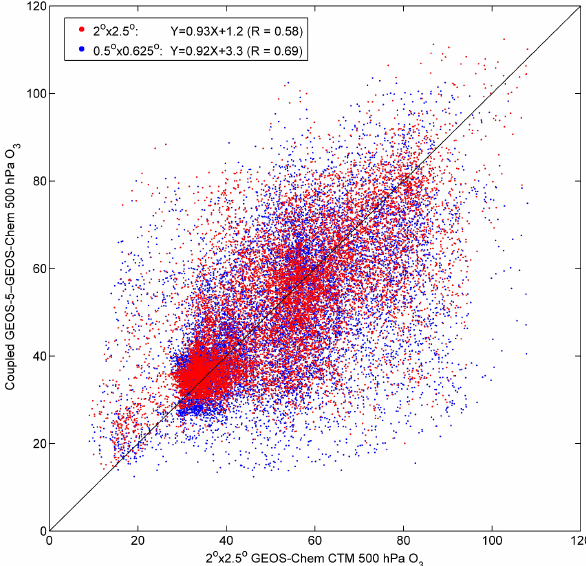
Figure 4. Comparison of instantaneous 500hPa ozone mixing ra- tios (nmolmol − 1 ) at 12:00UT on 15 July 2006 in the stand-alone GEOS-Chem simulation at 2 ◦ × 2 . 5 ◦ horizontal resolution and the coupled GEOS-5–GEOS-Chem simulation at 2 ◦ × 2 . 5 ◦ (red) and 0 . 5 ◦ × 0 . 625 ◦ (blue) resolutions. The 0 . 5 ◦ × 0 . 625 ◦ results are re- gridded to 2 ◦ × 2 . 5 ◦ resolution, and each point represents a 2 ◦ × 2 . 5 ◦ grid square. The reduced-major-axis regression parameters and the 1 : 1 line are also